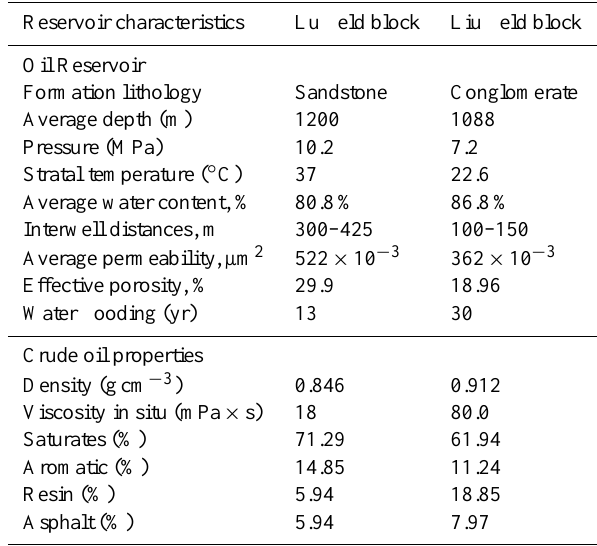
Table 1. Reservoir characteristics of Lu and Liu field block.